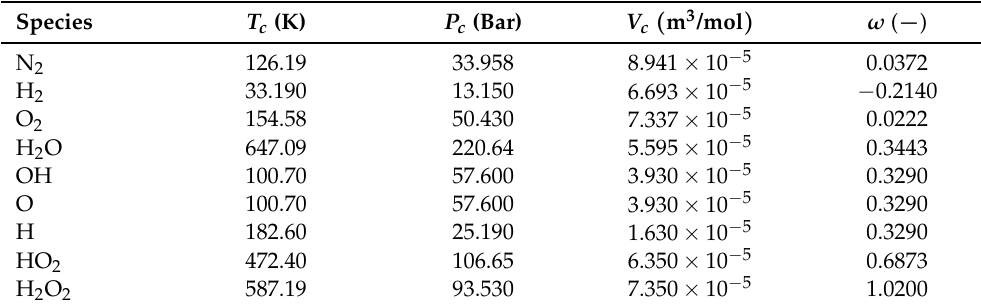
Table 1. Critical properties of the species considered in the present article; T c P c ,V c and ω are, respectively, the critical temperature, pressure, molar volume and acentric factor. Sources: [26] for N 2 , H 2 , O 2 and H 2 O; [27] for H, O, OH and H 2 O 2 . HO 2 data were estimated through the CRANIUM code [28] that is based on the molecular description and group contribution strategies: Joback’s method [29] for critical temperature and volume and Lydersen’s method [30] for critical pressure; Pitzer’s expression of vapor pressure for the acentric factor [2] (Sections 2.3, 7.2 and 7.4). Species T c (K) P c (Bar) V c ( m 3 /mol